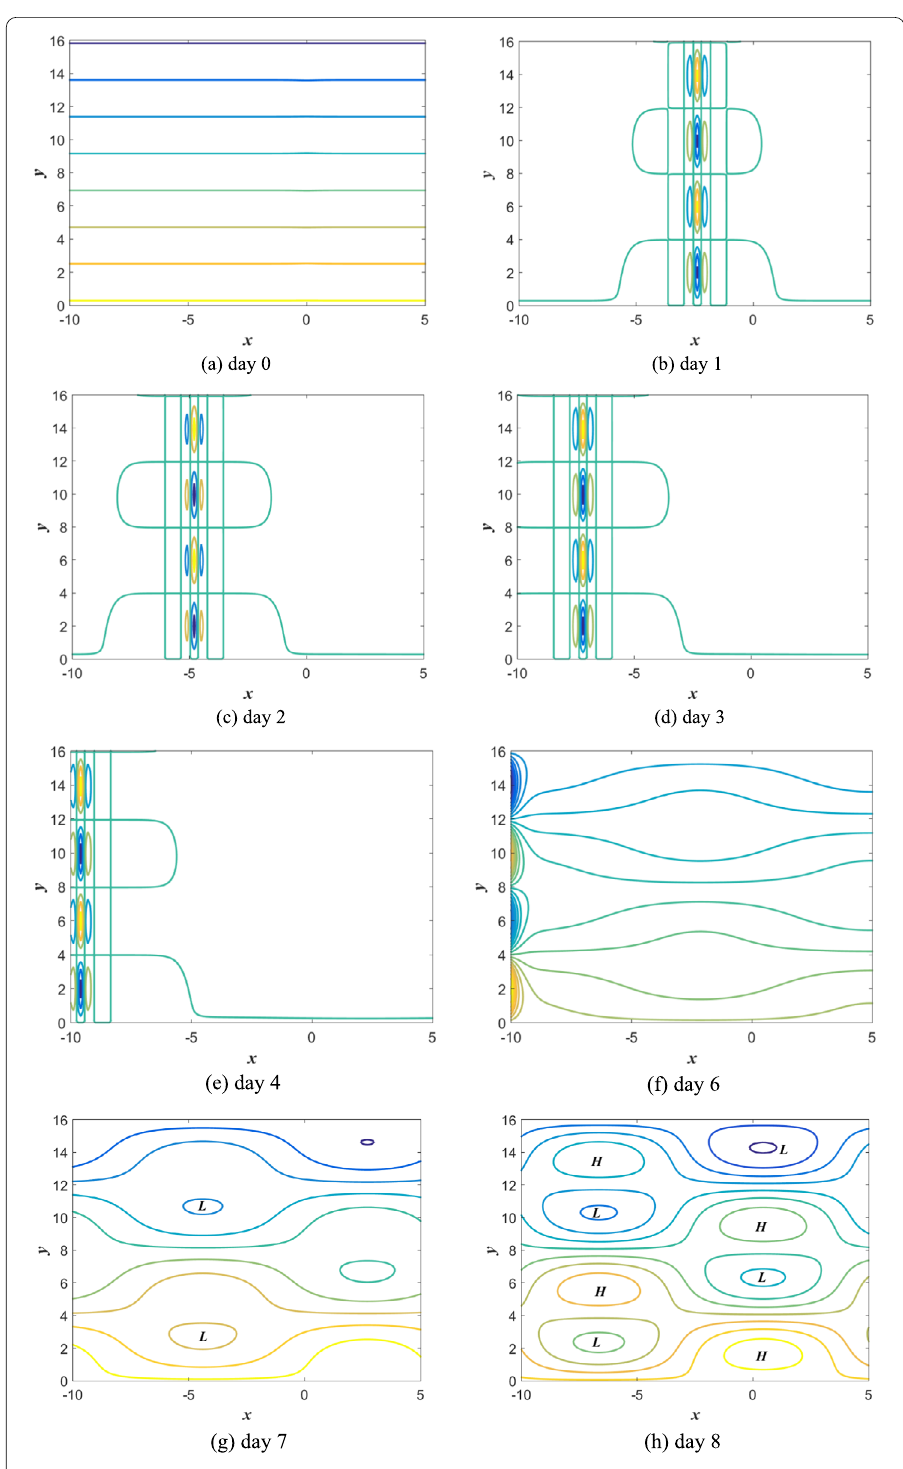
Figure 1 When a 1 = c 1 sin( ε 3/2 t ), a 2 = c 2 , a 3 = c 3 cos( ε 3/2 t ), a 4 = c 4 , the evolution of stream function field, the stream function analytic expression is Eq. (43), where R = k 1 sech[20 ε c 2 = 5.3, c 3 = 1.3, c 4 = 0.6, β = 16.3, b 0 = –18, b 1 = 5, n 0 = 5.2, m = 1.4, ε = 0.1, k = 6, k 1 =